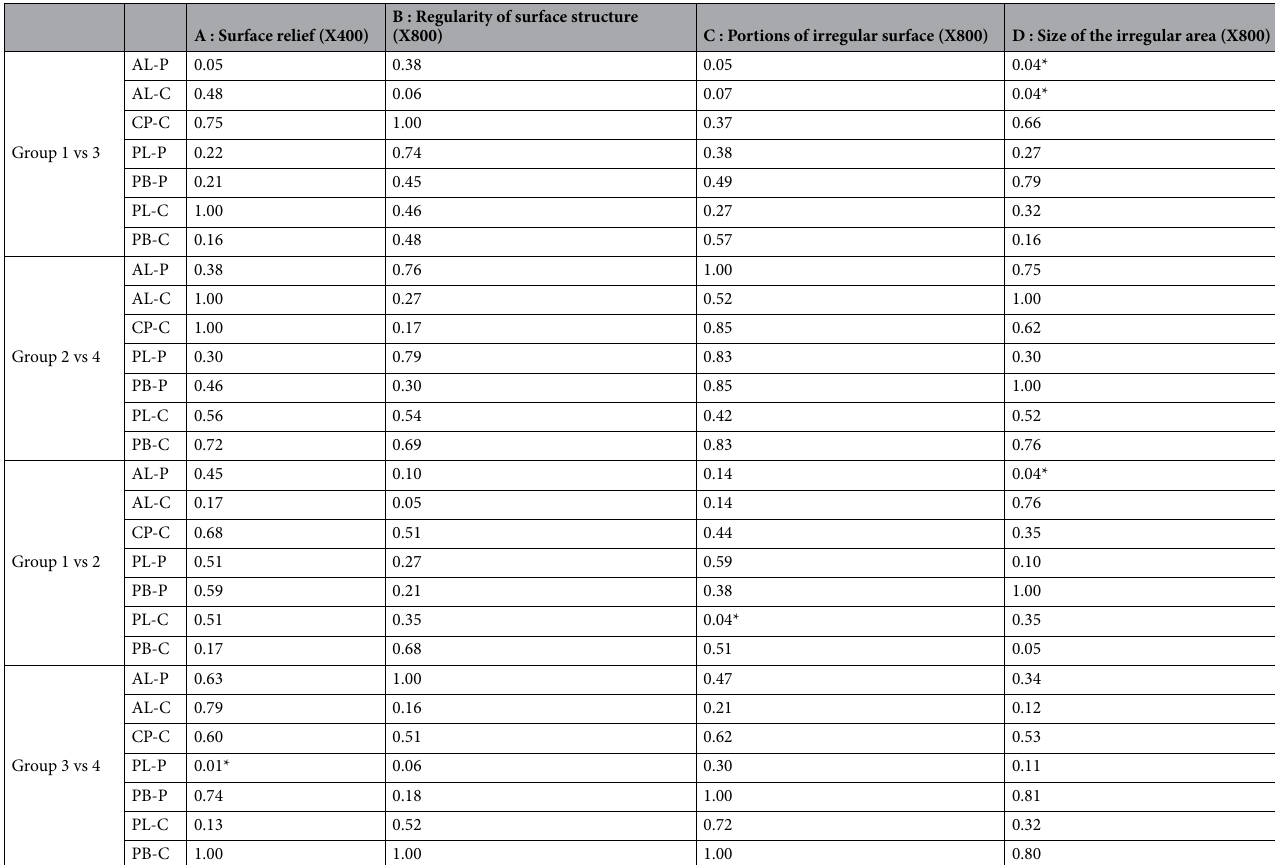
Table 3. P values comparing various groups. Group 1: 32% laser power for − 2.0D treatment), group 2: 64% laser power for − 2.0D treatment, group 3: 32% laser power for − 5.0D treatment and group 4: 64% laser power for − 5.0D treatment). The anterior lenticular surface periphery & centre, anterior cap centre, posterior lenticular periphery & centre and posterior stromal base centre and periphery scans were analysed. (AL-P = anterior lenticule surface periphery; AL-C = anterior lenticule surface centre; CP-C = centre of cap’s posterior surface; PL-P = posterior lenticule surface periphery; PB-P = posterior stroma base periphery; PL-C = posterior lenticule surface centre; PB-C = posterior stroma base centre.) *statistically